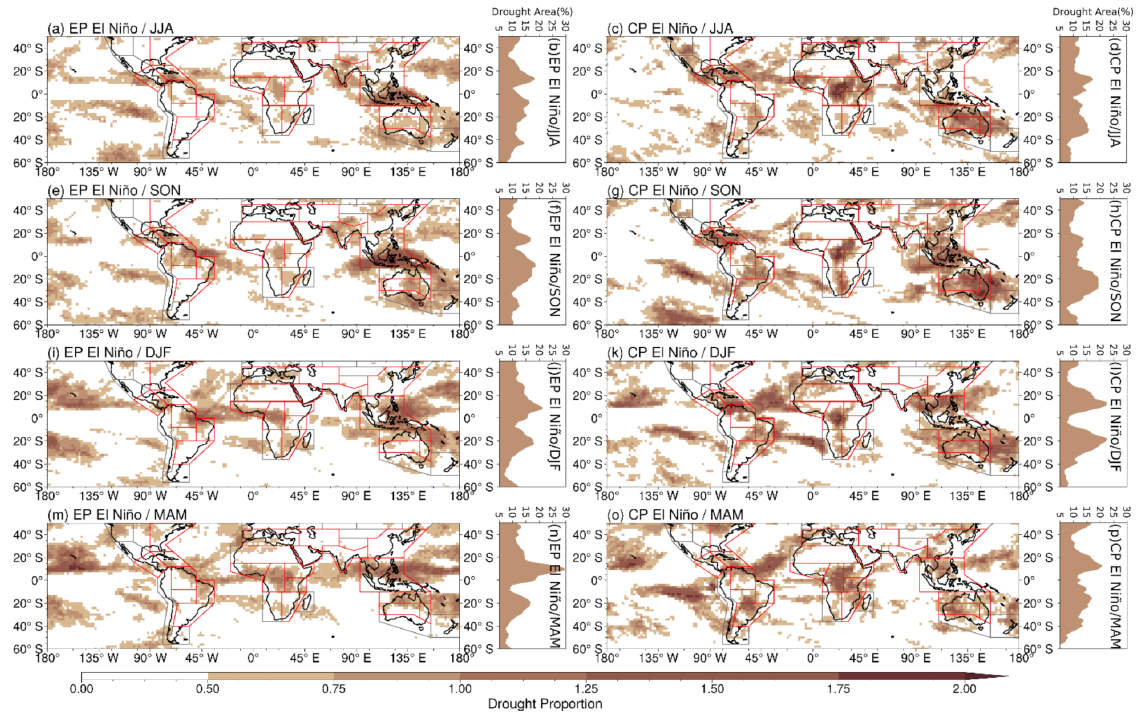
Figure 6. The same as Figure 4, but for EP El Niño and CP El